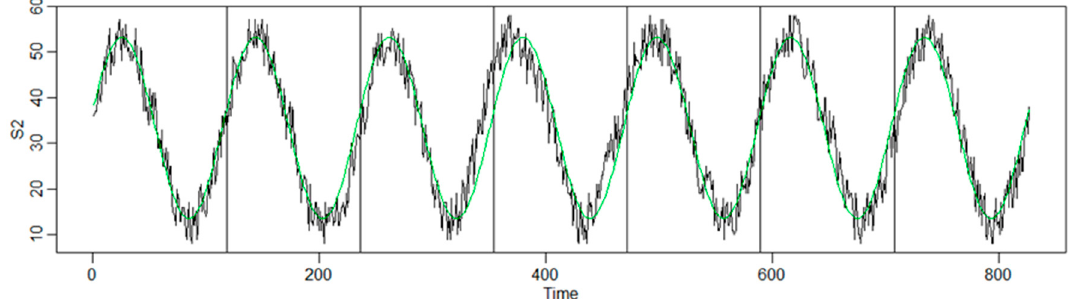
Figure 11. Theoretical series versus the real series and the fundamental frequency (own elaboration). Legend: black line = original data series; green line = harmonic series; vertical black line = periods.